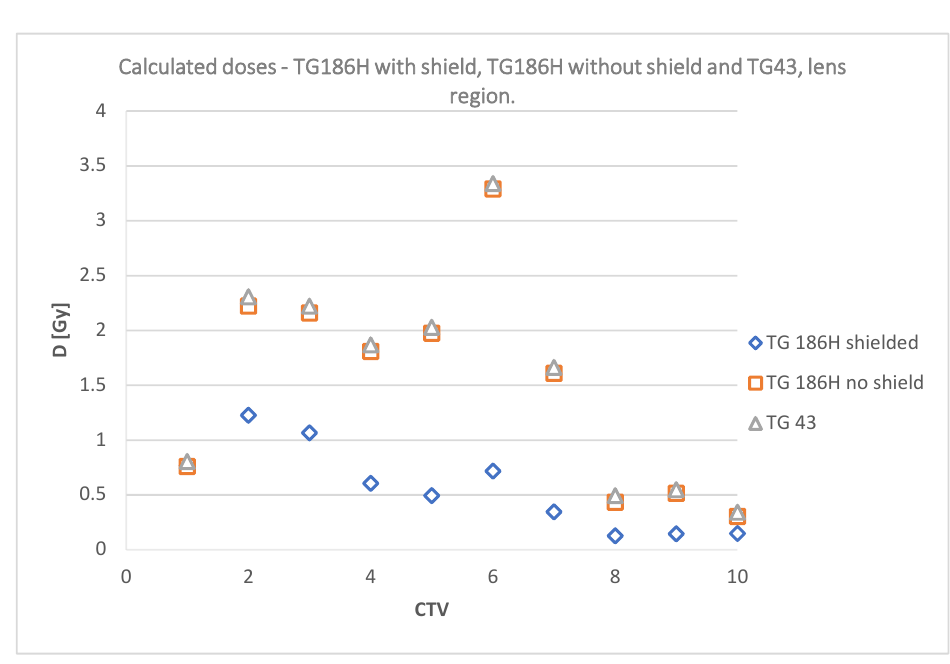
Figure 14. Calculated dose comparison—TG186H with shield, TG186H without shield, and TG43 at a point in the lens of the eye.